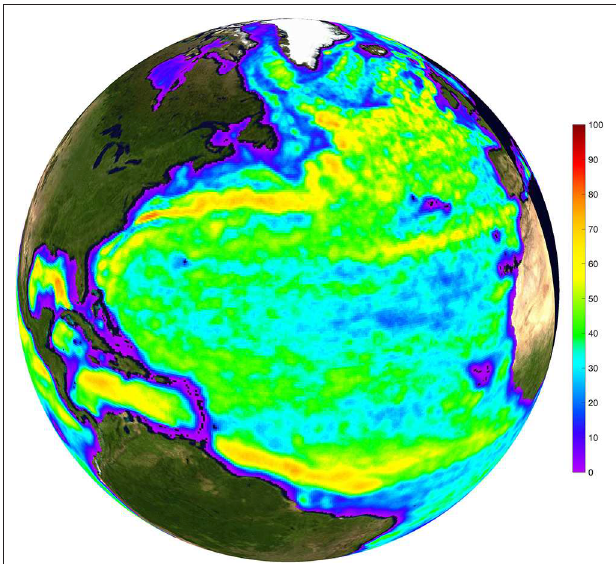
FIGURE 1 | Map of the percent of time that an individual 1 / 4 ◦ pixel is located within the interior of mesoscale eddies or meanders, as defined by the outermost closed contour of SLA defining a coherent mesoscale structure.